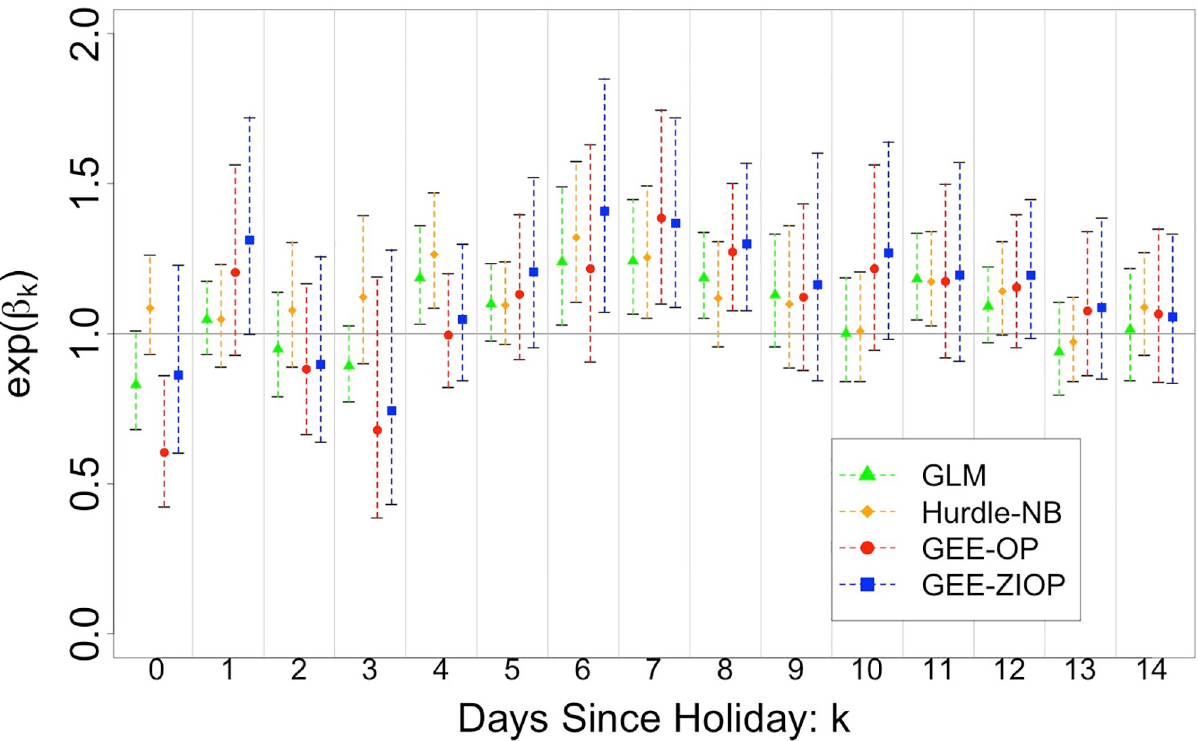
Fig 2. Incidence rate ratio with robust 95% confidence interval for holiday effects. Estimated IRRs corresponding to the 15 holiday covariates, for each model. 95% confidence intervals were calculated using robust standard errors.